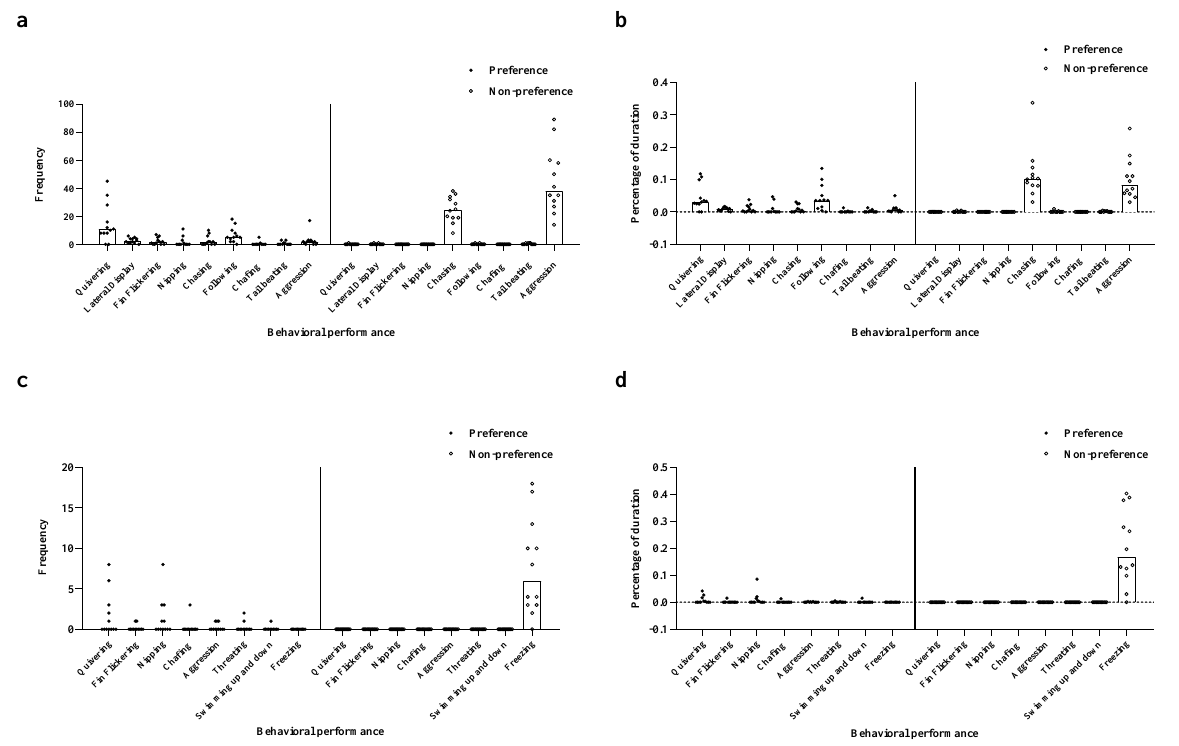
Figure 1. The behavioral intention of male and female fish in Experiment 1. ( a ) Frequency of male’s behavioral performance; ( b ) Proportion of duration of behavioral performance in males; ( c ) Frequency of female’s behavior performance; ( d ) Proportion of the duration of behavior performance in